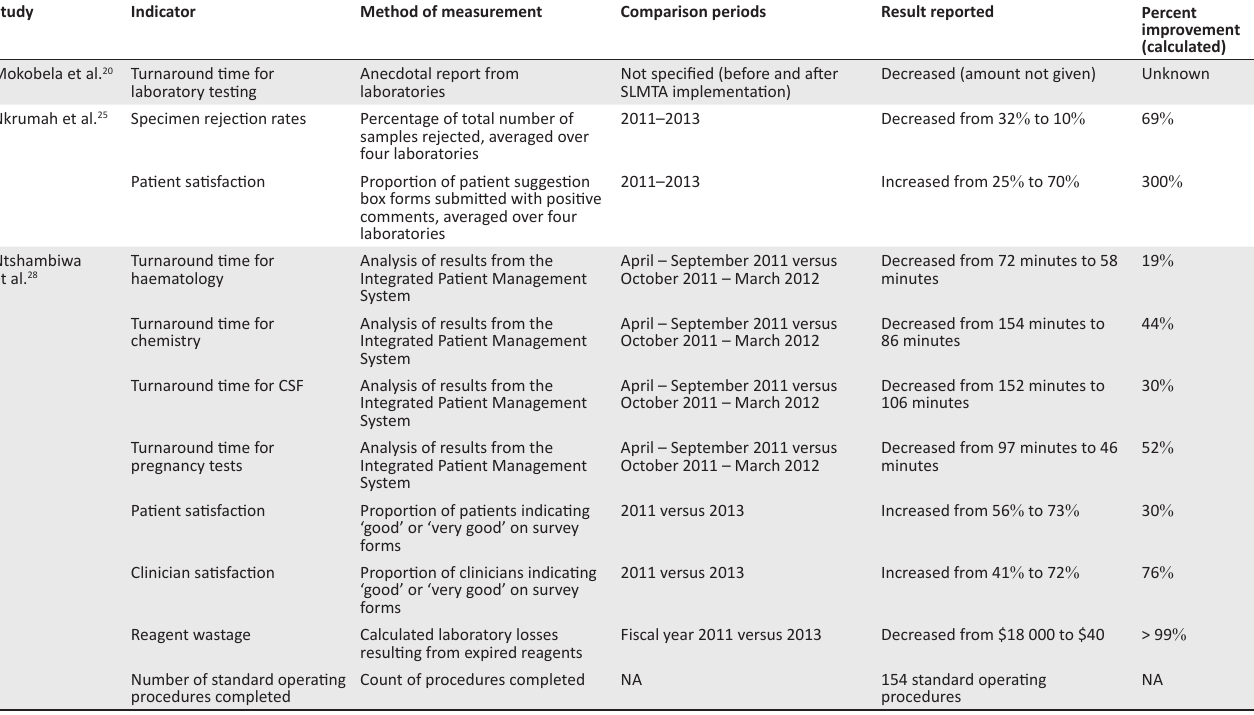
TABLE 2 (Continues...): Health service indicators associated with SLMTA implementation as reported in published studies. Study Indicator Method of